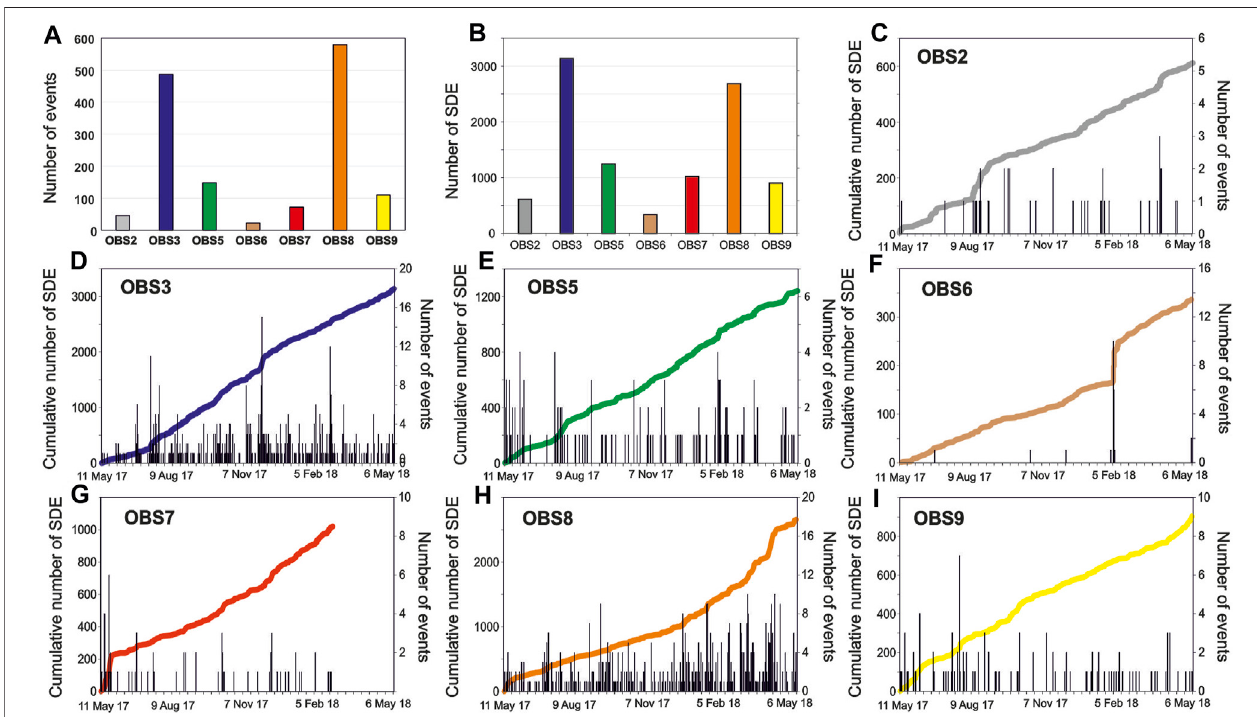
FIGURE 9 | (A) Histograms of the number of single station earthquakes recorded only by the single OBS (B) Histograms of the number of SDE recorded by the single OBS (C – I) Comparison between the number of SDE and the number of single station events recorded at each OBS.